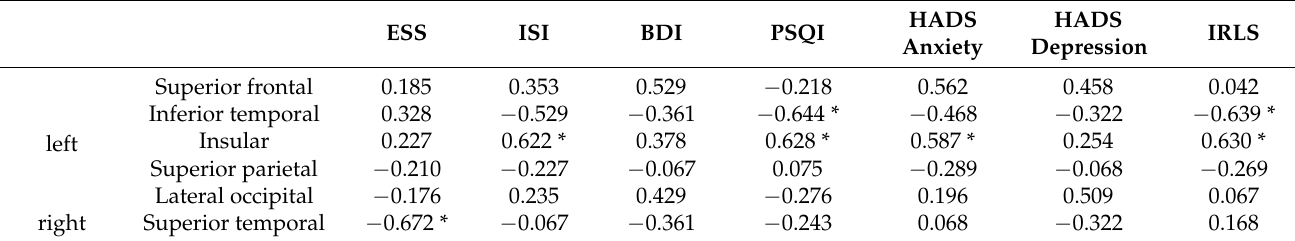
Table 1. Correlations of critical regions’ activities and clinical